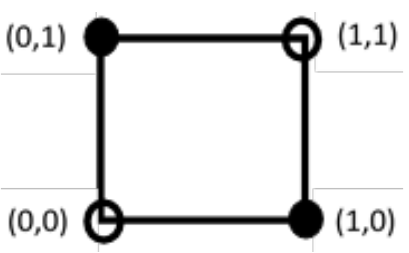
Figure 1. The points (0,1) and (1,0) are not linearly separable.